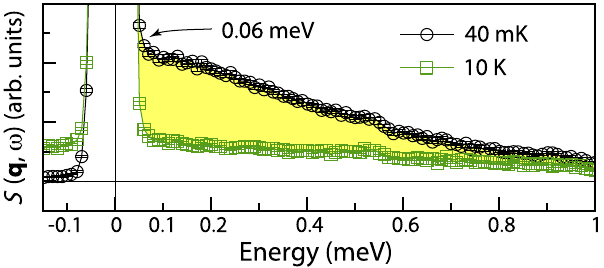
FIG. 6. Spin-excitation energy spectra at K 1 position measured with E i ¼ 1 . 55 meV at T ¼ 40 mK (black circles) and 10 K (green squares). The yellow shaded area marks the difference between the spectra for T ¼ 40 mK and 10 K. The black arrow marks the lowest energy (0.06 meV) magnetic